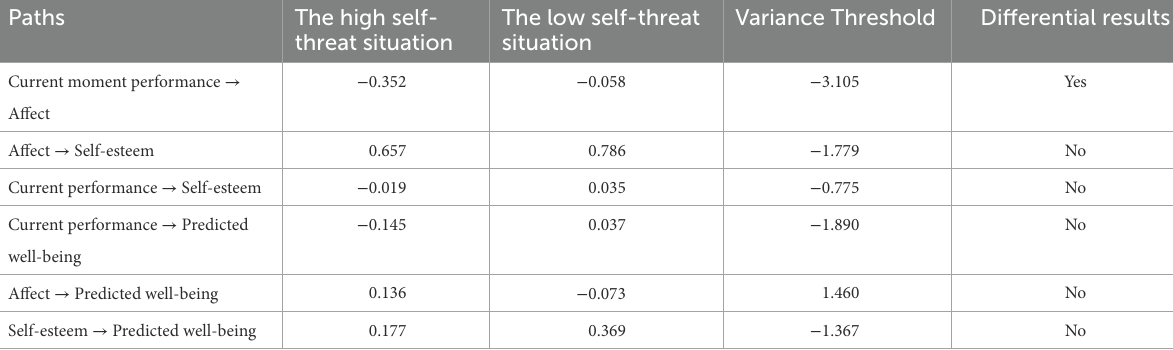
TABLE 5 Comparison of differences in path coefficients of high and low self-threat clusters. Paths The high self- The low self-threat threat situation